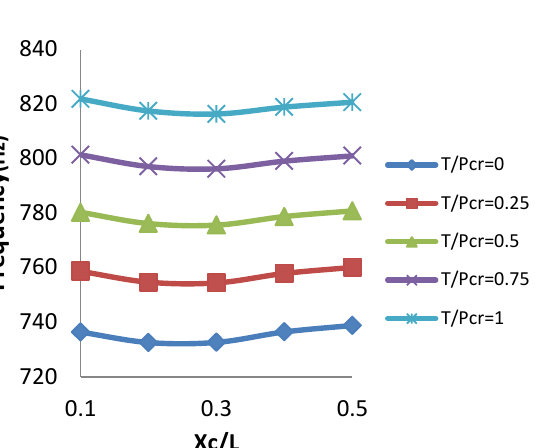
Fig. 5. Second frequency of cracked beam, subject to Tensile